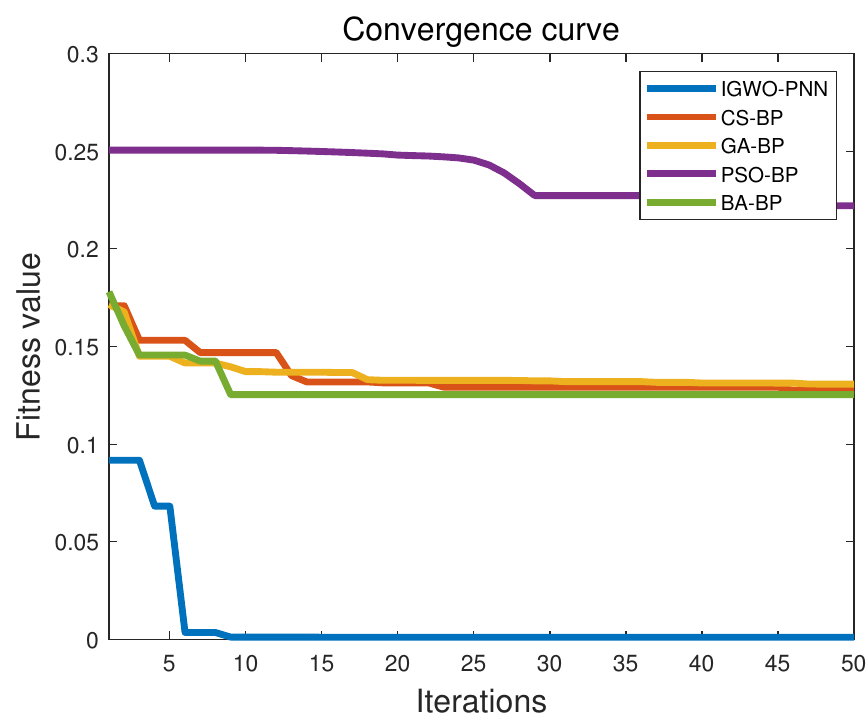
Figure 13. The fitness curve of different methods in the third set of comparative